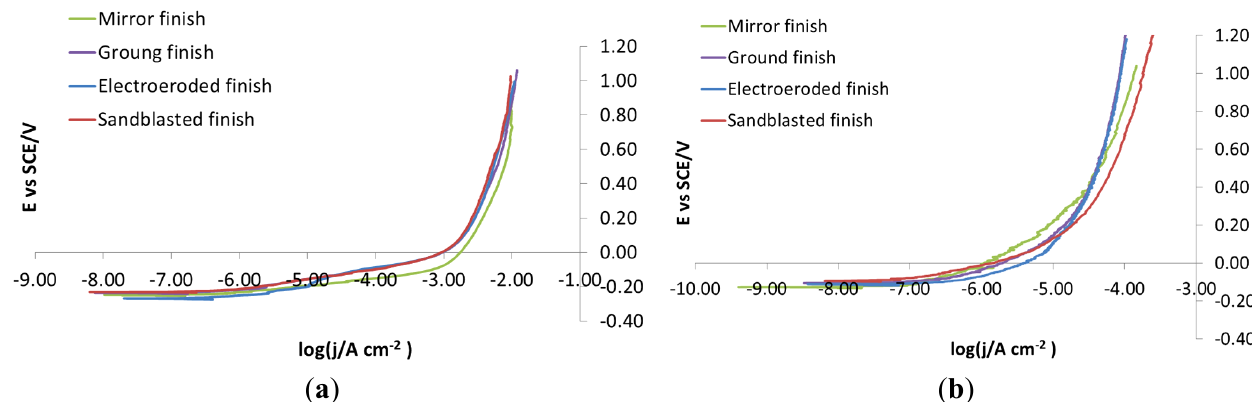
Figure 5. X105CrCoMo18-2 bare steel: polarization curve on different finishes. ( a ) NaCl 0.1 M; ( b ) NaCl 0.001